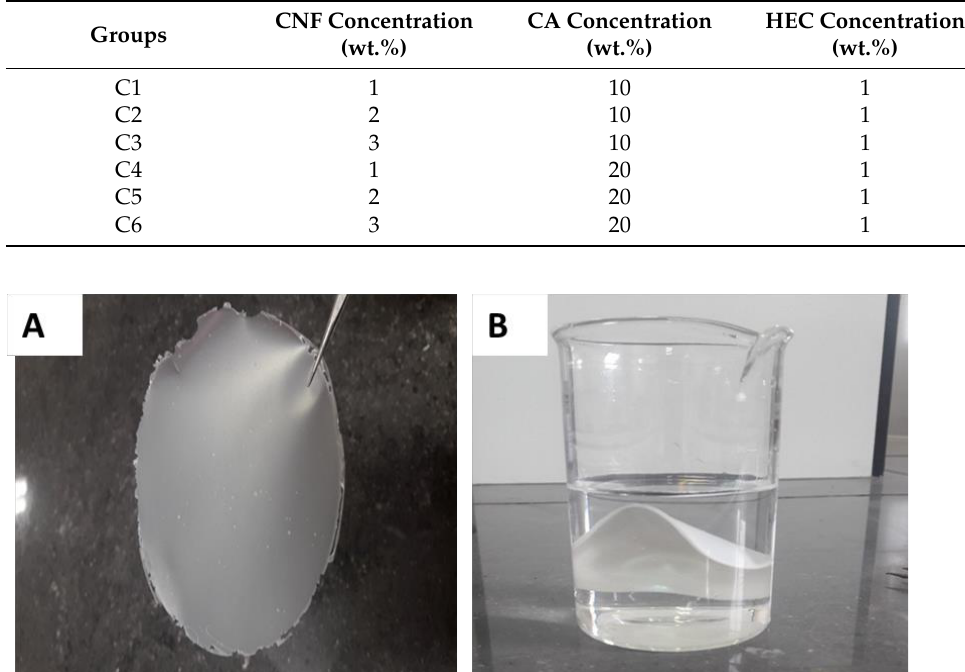
Table 1. Sample denotation.